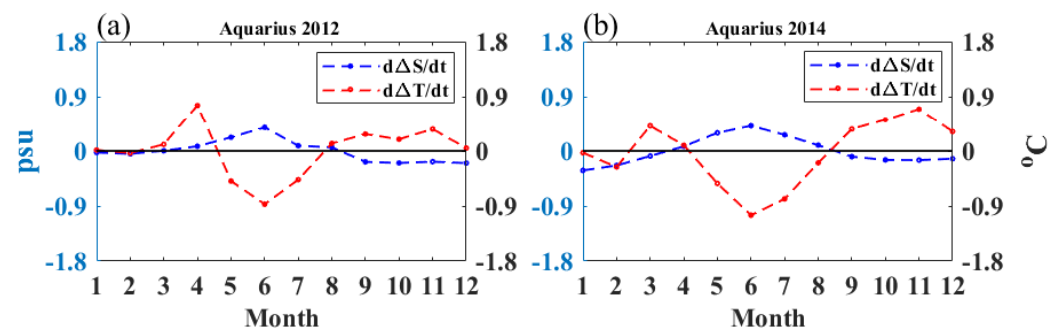
Figure 4. Same as Figure 2 but for SSS data obtained from Aquarius.